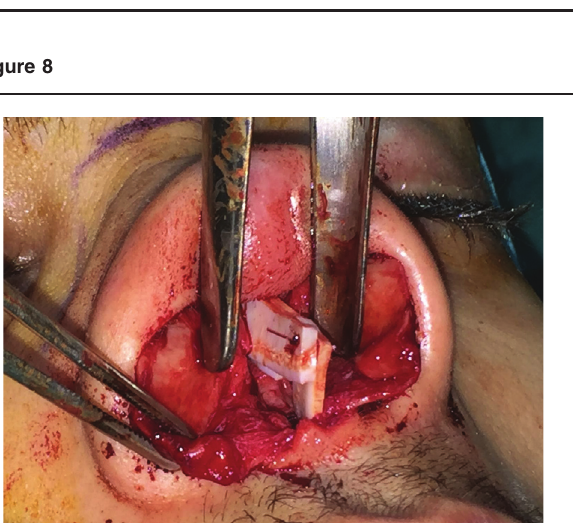
Septal L-strut reconstruction fixed before trimming excess cartilage.